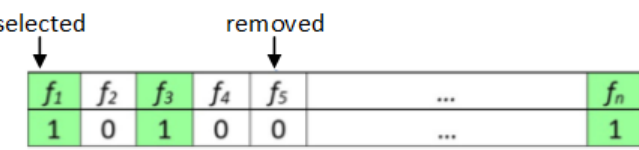
Figure 11. A pattern of binary solution for a dataset of n